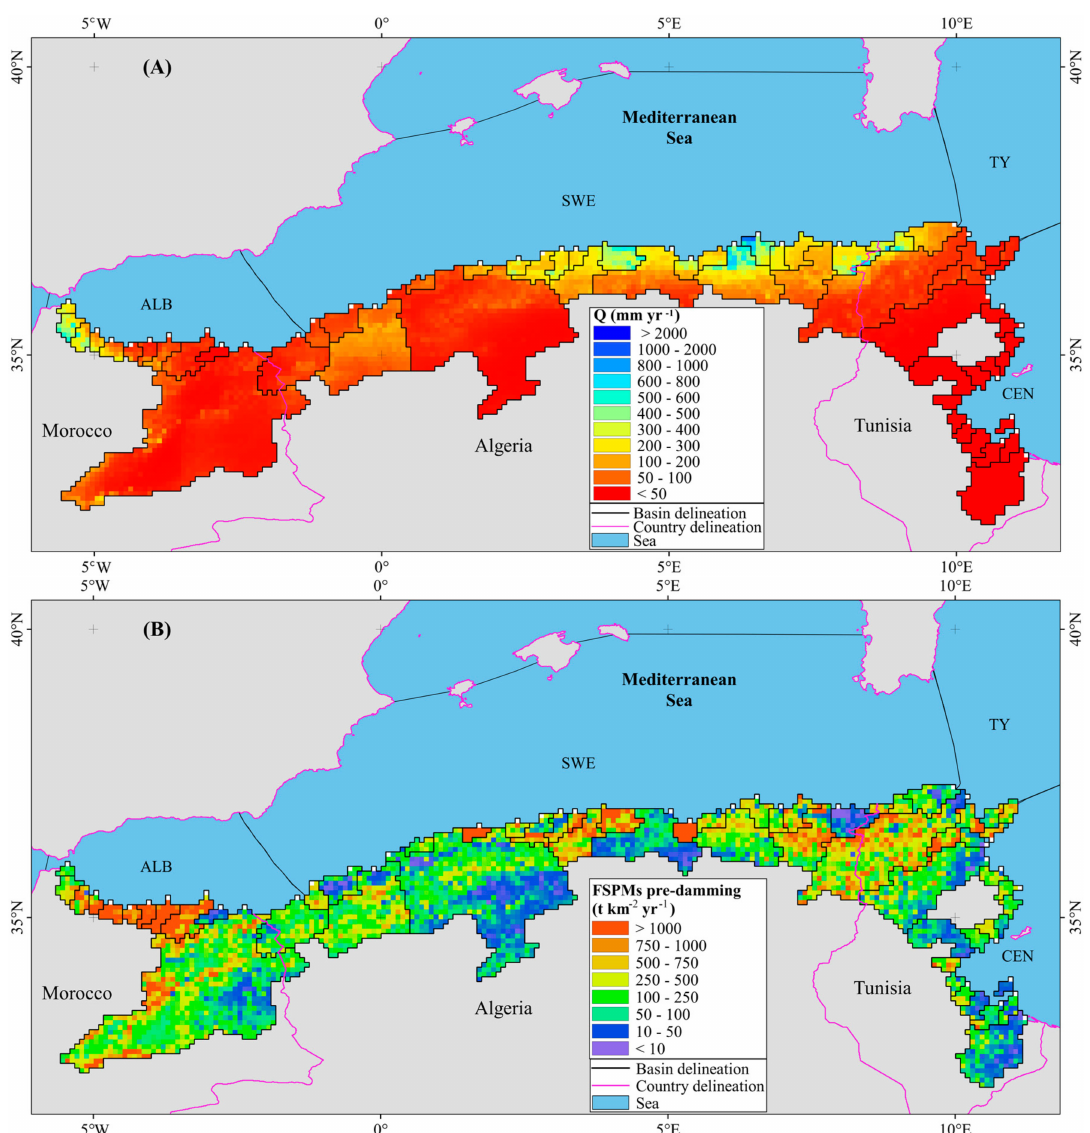
Figure 3. Spatial distribution of ( A ) specific riverine water discharge (Q-mod) and ( B ) specific suspended particulate matter fluxes (FSPMs pre-damming) in the Mediterranean Maghreb Basin according to the study of